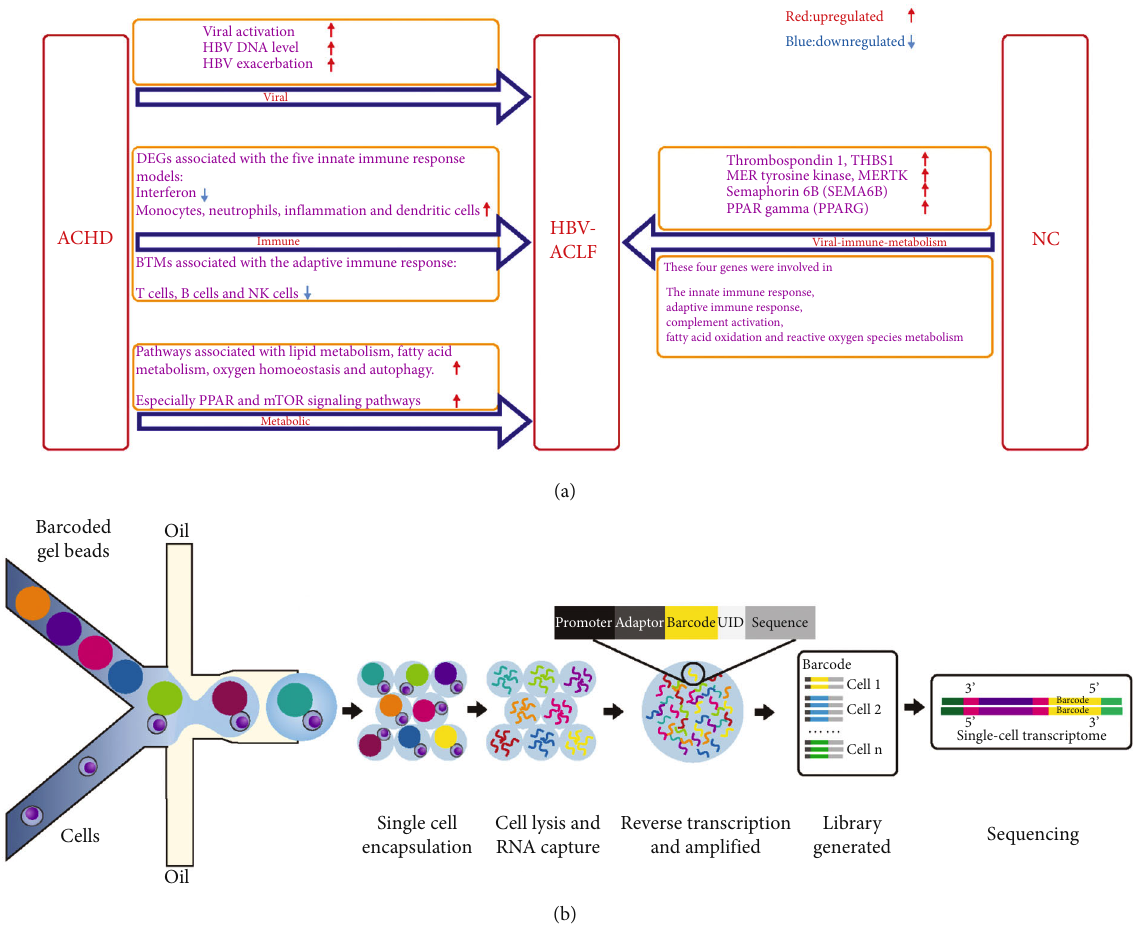
Figure 4: (a) PBMC transcriptomics in the HBV-ACLF expression. (b) Technology of single-cell RNA